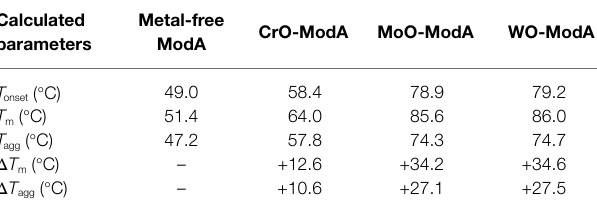
TABLE 1 | NanoDSF analyses of metal-free and metal-bound